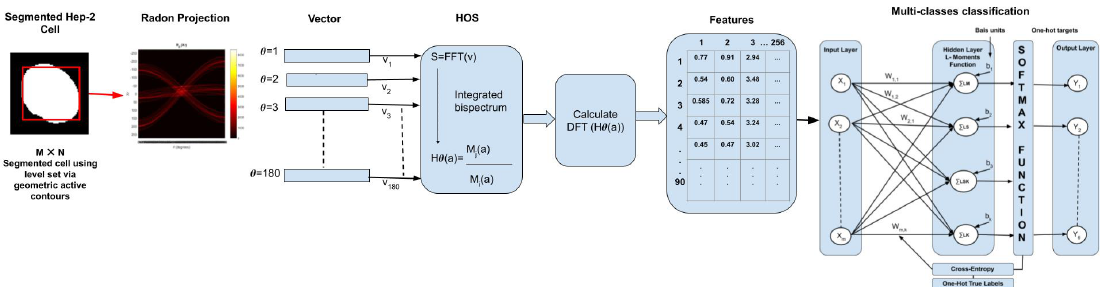
Figure 1. Proposed method processes to classify HEp-2 cell level patterns, including segmentation, feature extraction and multi-classes classification using adapted MLP neural network with two